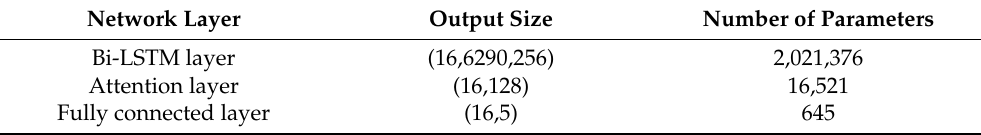
Table 4. The output and parameters of each network layer.